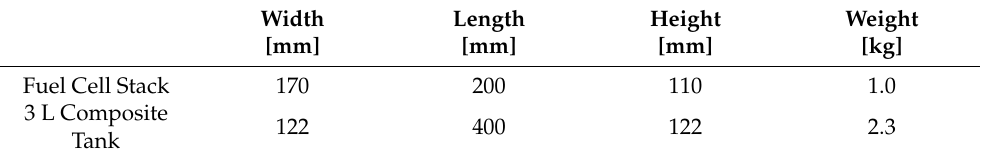
Table 6. Fuel Cell System Initial Sizing.